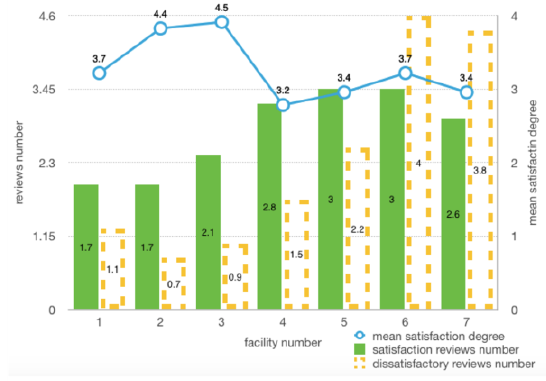
Figure 1. Relationship between the number of facilities and reviews